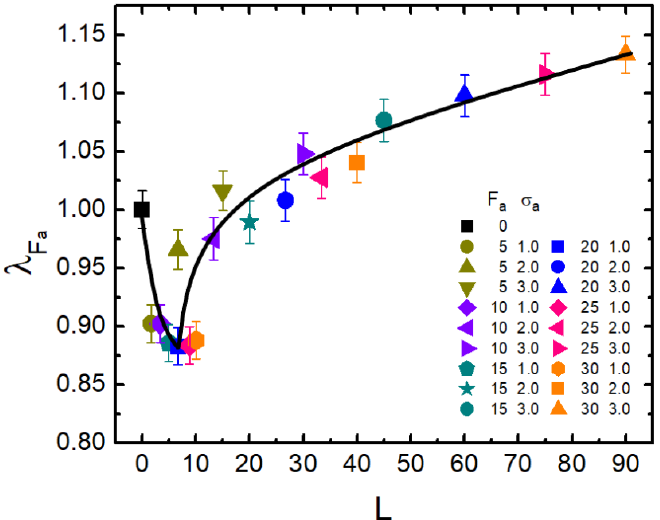
Figure 5. The scaled gyration radius λ F is plotted versus dynamical persistence length L for φ = 0.1 a and κ = 1.0. Error bars correspond to one standard